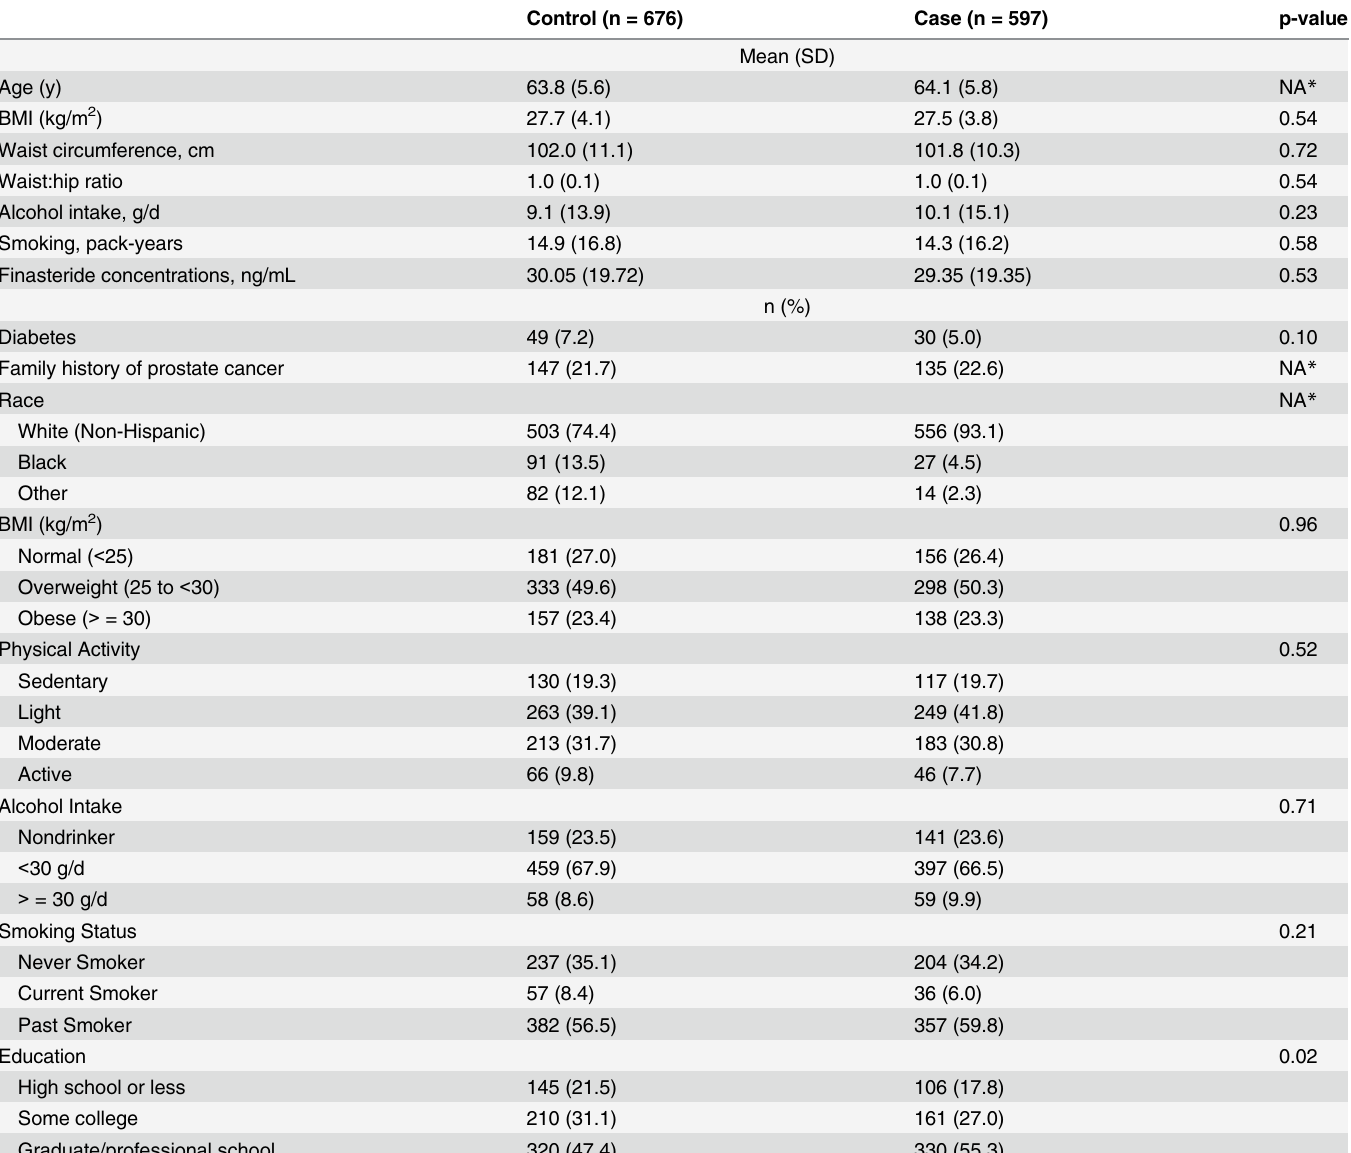
Table 1. Demographics and lifestyle characteristics of cases and controls of the Prostate Cancer Prevention Trial participants in the treatment arm (n =